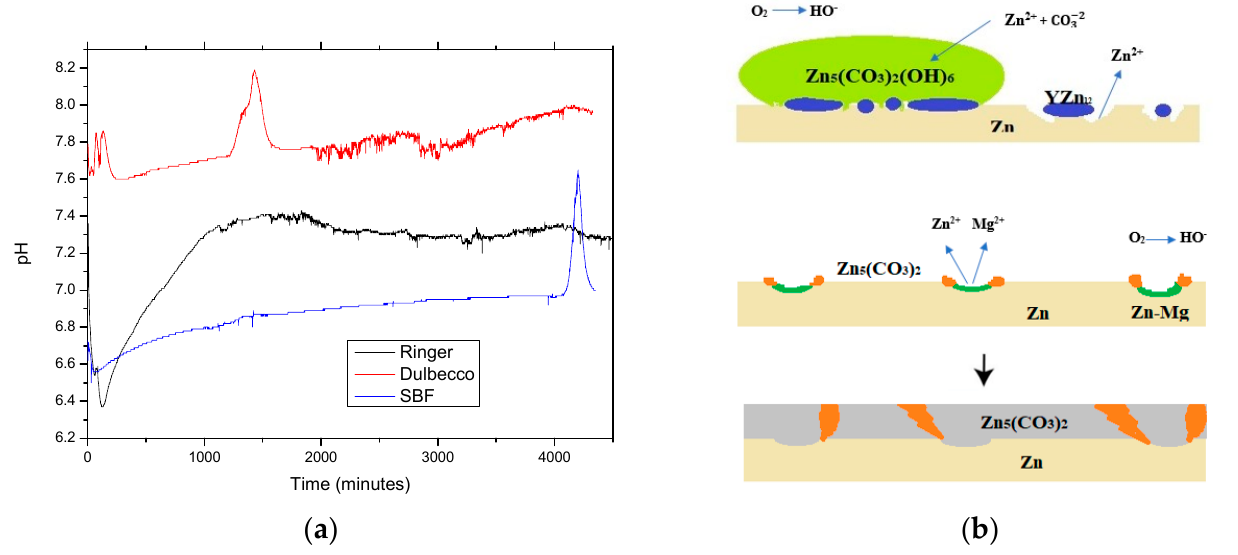
Figure 2. ( a ) pH variation of the immersion solution with ZnMgY and ( b ) a schematic of the corrosion process of the Zn-based alloy in an aqueous solution.